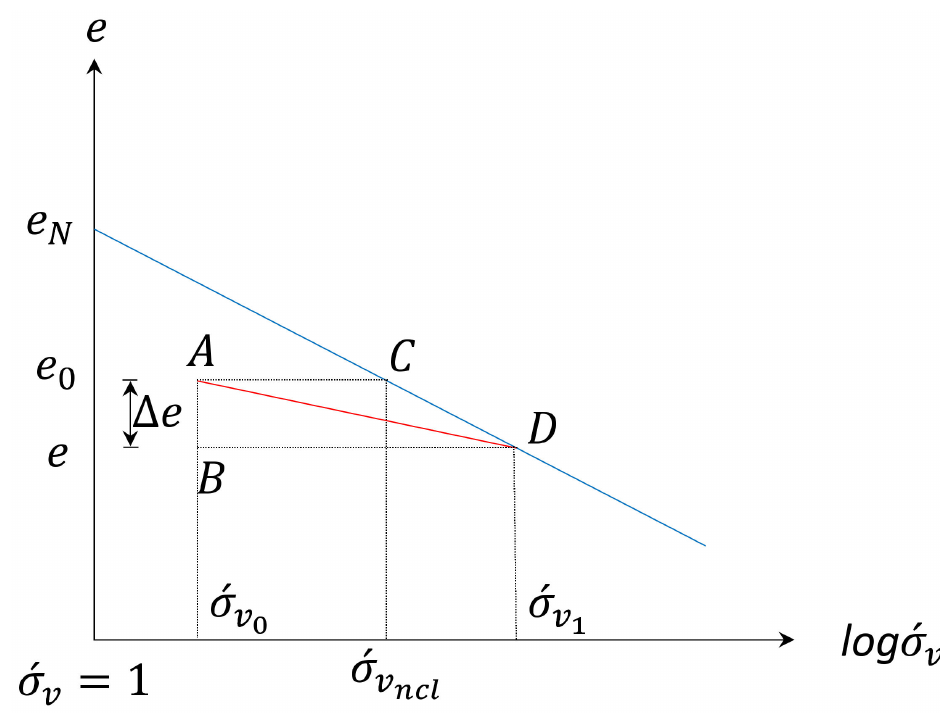
Figure 13. Relationship of compression index, recompression index and coefficient of volume decrease.